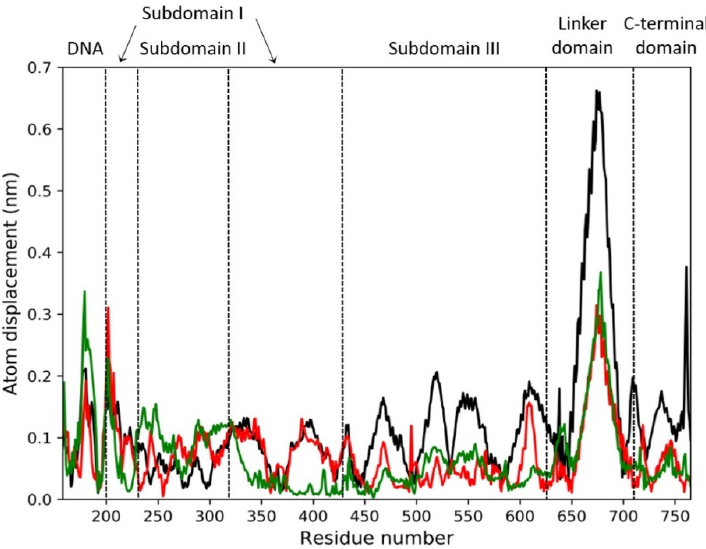
Figure 7. Atomic displacement calculated for each of the 565 C-alpha atoms of htopIB and each